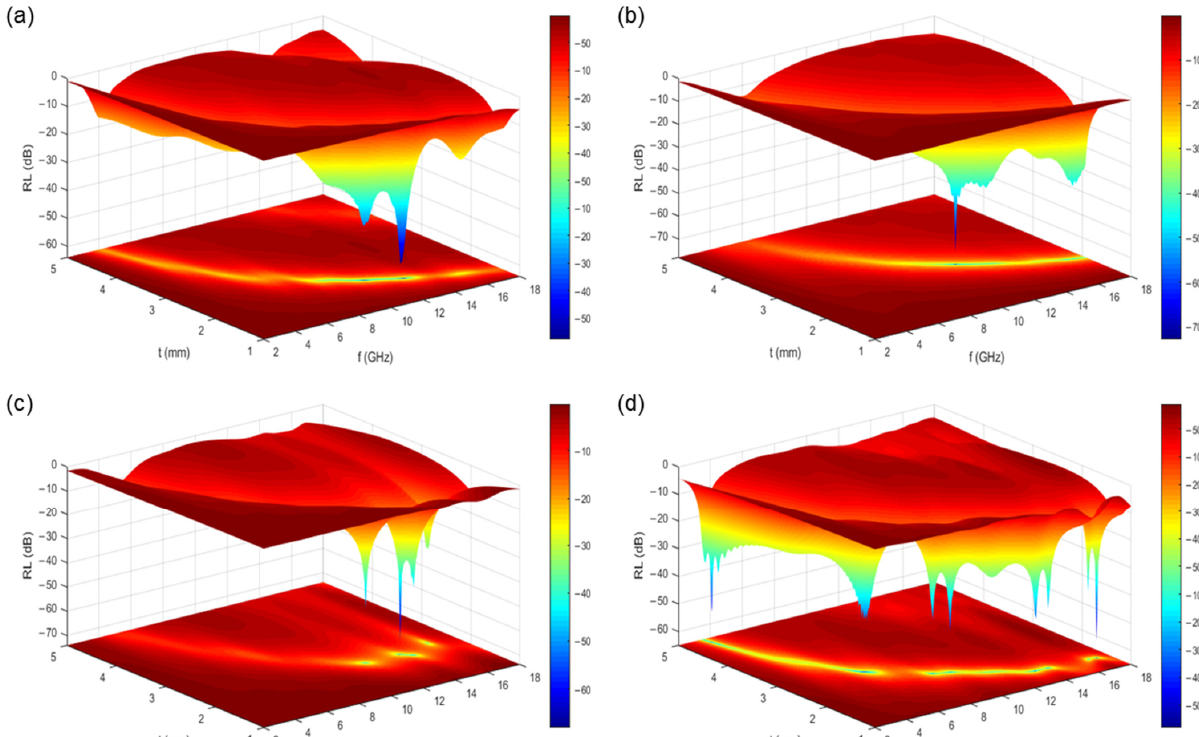
◦ C pyrolysis: ( a ) S-0, ( b ) S-16, ( c ) S-32, ( d ) Figure 4. RL of Ni-doped ZIF-67 after 800 °C pyrolysis: ( a ) S-0, ( b ) S-16, ( c ) S-32, ( d ) S-64. Figure 4. RL of Ni-doped ZIF-67 after 800